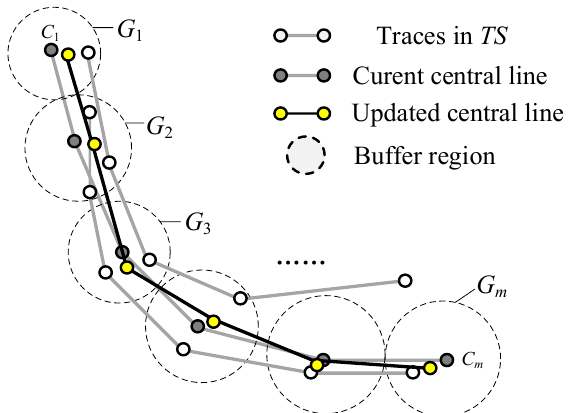
Figur e 8. Delineating road intersection structures by iterative piecewise fitting algorithm Figure 8. Delineating road intersection structures by iterative piecewise fitting